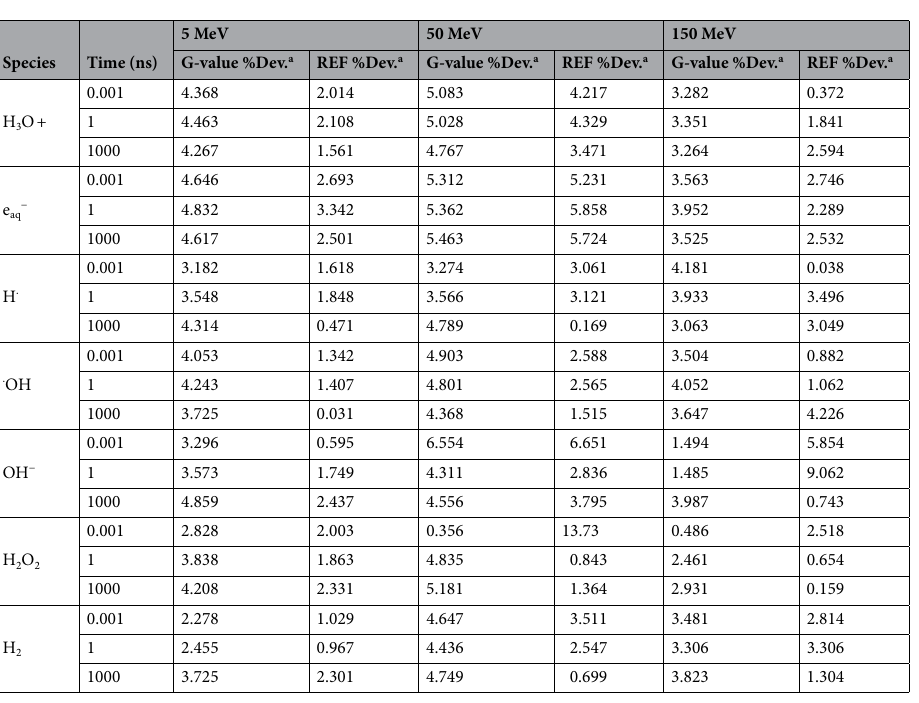
5 MeV 50 Species Time (ns)